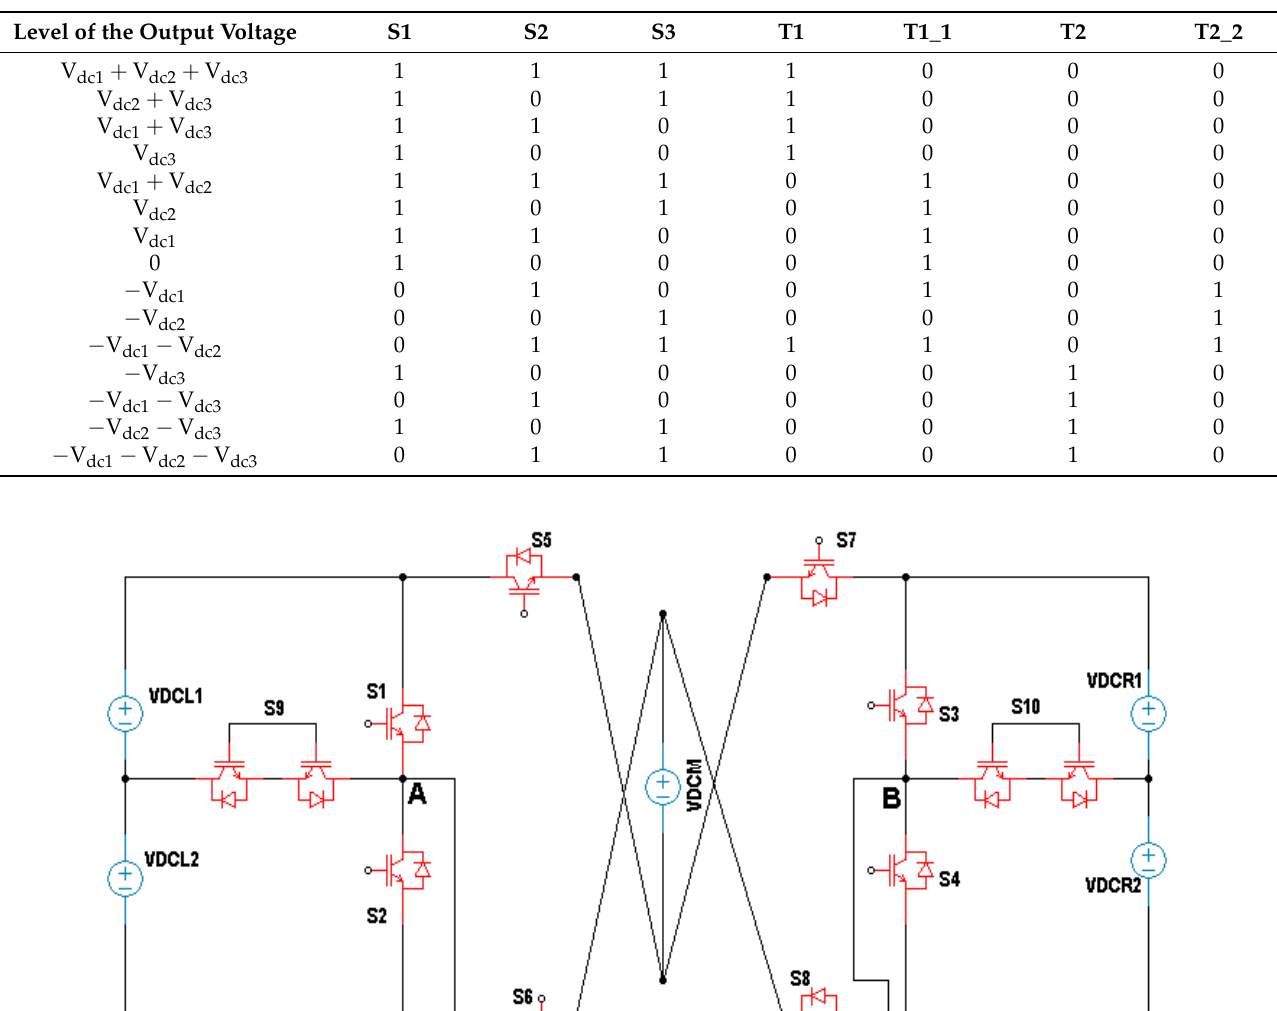
Table 1. Output voltage and switch status for a modified 15-level T-MLI.